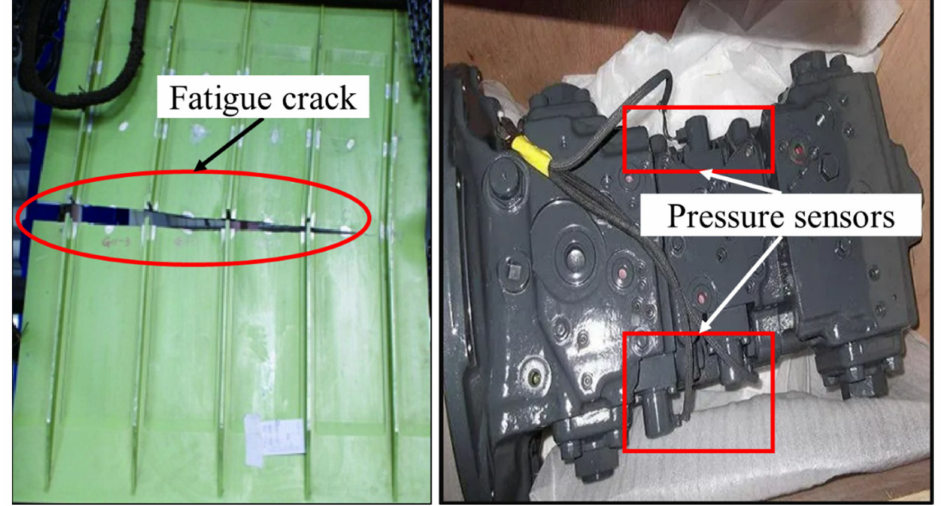
Figure 3. Crack in aircraft panel ( left ) and pressure sensor of hydraulic pump ( right